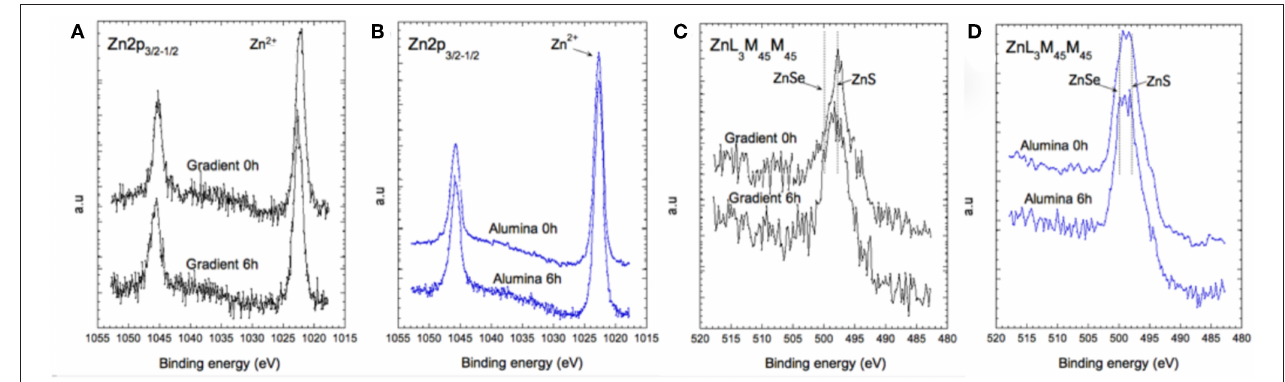
FIGURE 6 | XPS spectra of the Zn 2p core level (A,B) and of the Auger transition Zn L 3 M 45 M 45 (C,D) for the gradient shell sample and the aluminum treated sample at 0 and at 6h of